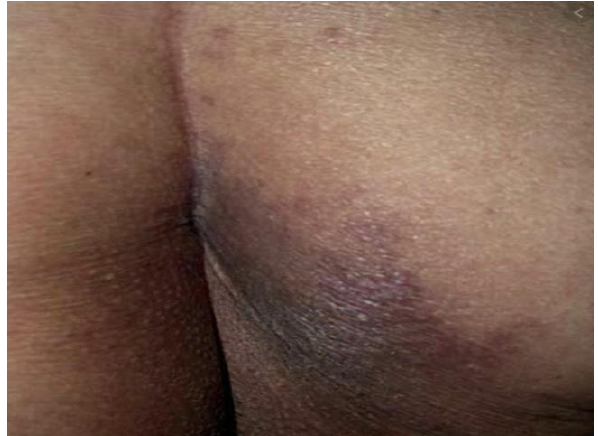
Figure 1 : Varicella Zoster Virus-induced rash in the S2-S4 dermatomal distribution.